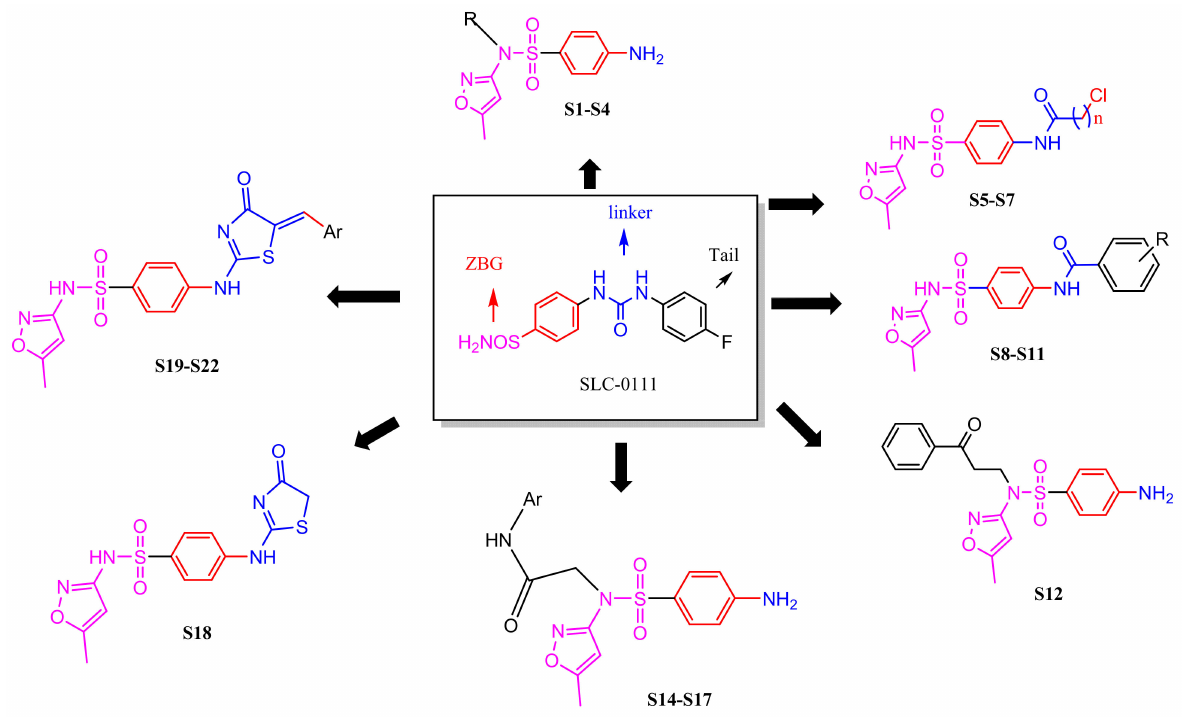
Figure 2. The main structural features and similarity of novel design h CA IX and XII inhibitors ( S1 to S22 ) with